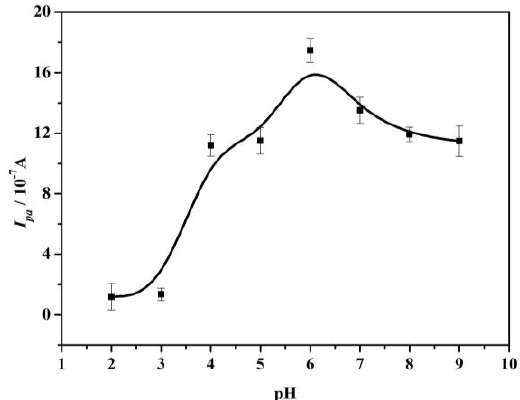
Figure 8. Influence of pH on the oxidation peak current of 1.0 × 10 −2 mol·L −1 AA. Each point represents the average of three replicates and the standard deviation of the mean.